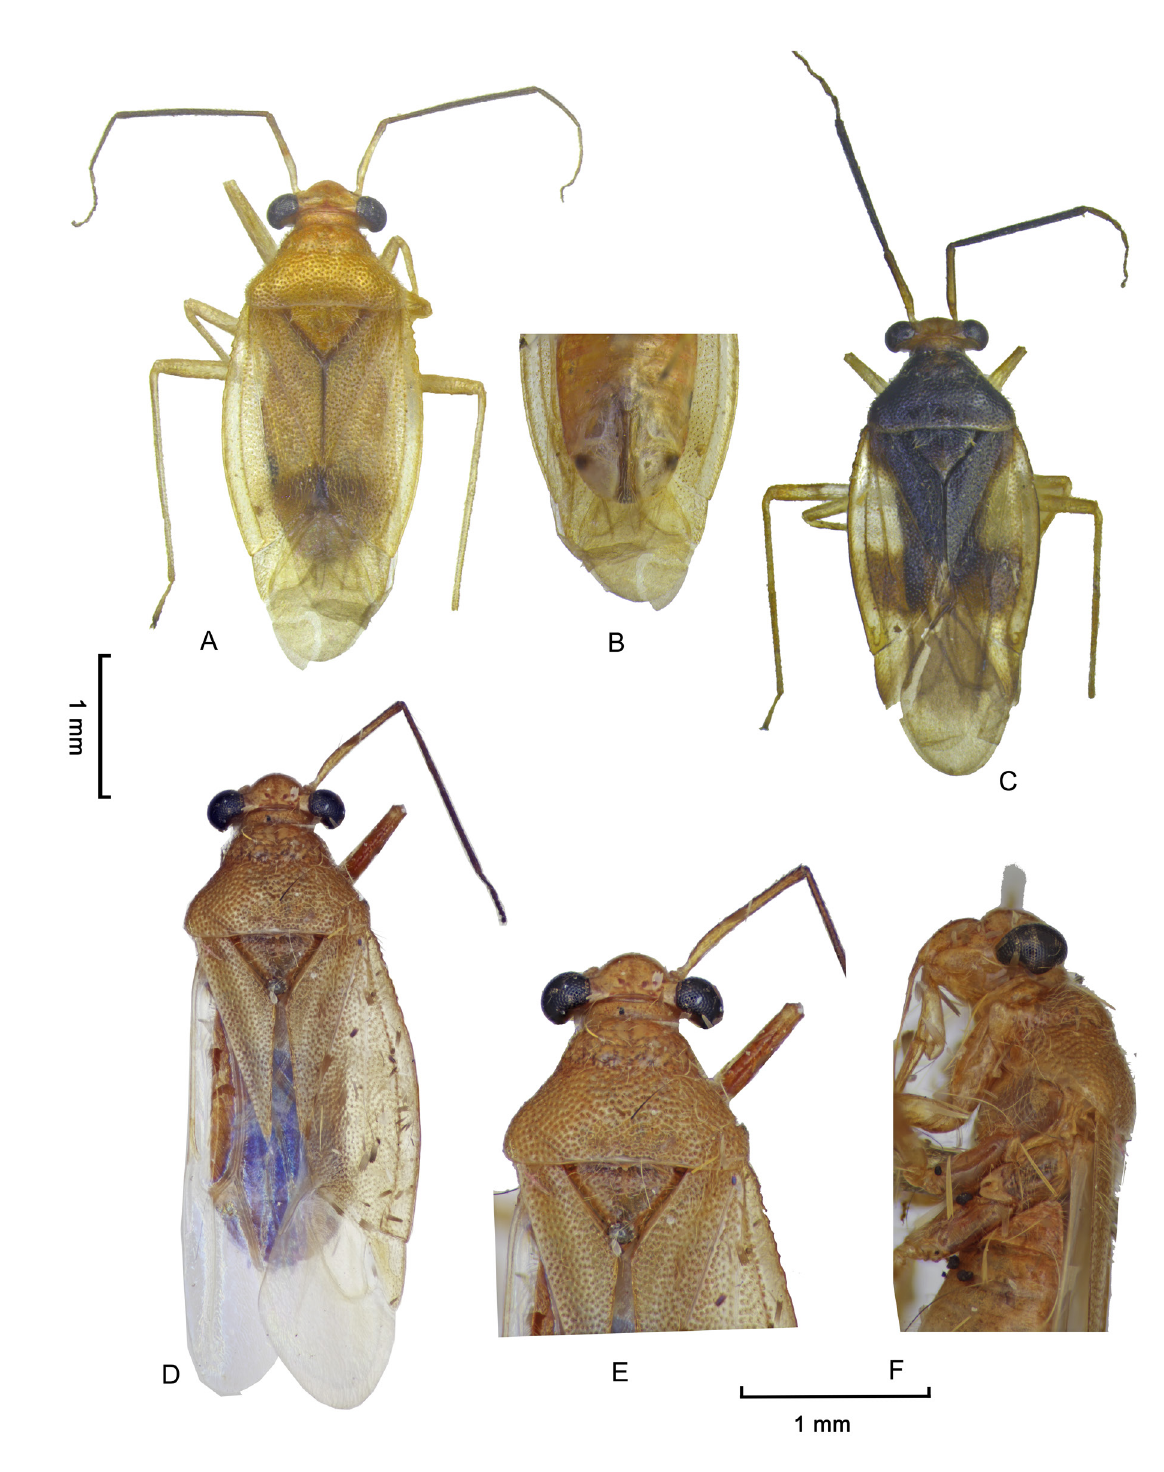
Fig. 1. Habitus of Dioclerus spp. A–B . Dioclerus bengalicus Stonedahl, 1988, ♀, UASB. A . Dorsal view. B . Abdomen in ventral view. C . Dioclerus lutheri Stonedahl, 1988, ♂, UASB, dorsal view. D–F . Dioclerus malayensis Stonedahl, 1988, ♀, paratype, AMNH_PBI 00340383, NHM. D . Dorsal view. E . Head and pronotum. F . Lateral